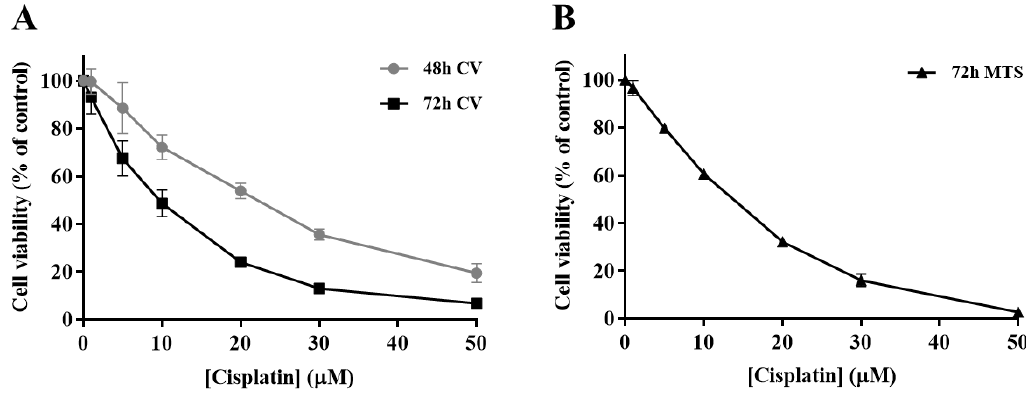
Figure 2. Cytotoxic effects of cisplatin (1–50 µM) in H1975 cells. The viability of cells treated with cisplatin for 48 h and 72 h was assessed by crystal violet (CV) staining assay ( A ) and for 72 h by MTS reduction assay ( B ). Values represent mean ± SD ( n = 3–4) and are expressed as percentages of the vehicle-treated control cells.